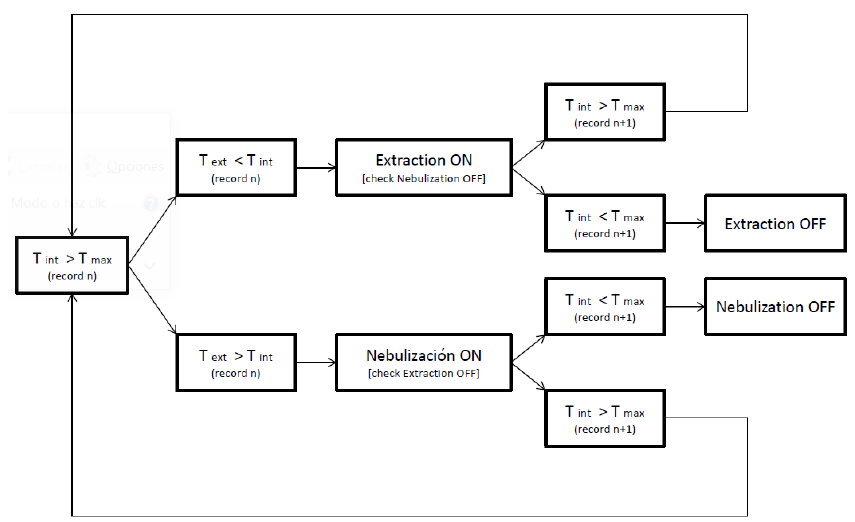
Figure 4. Control loops when T int> T max.